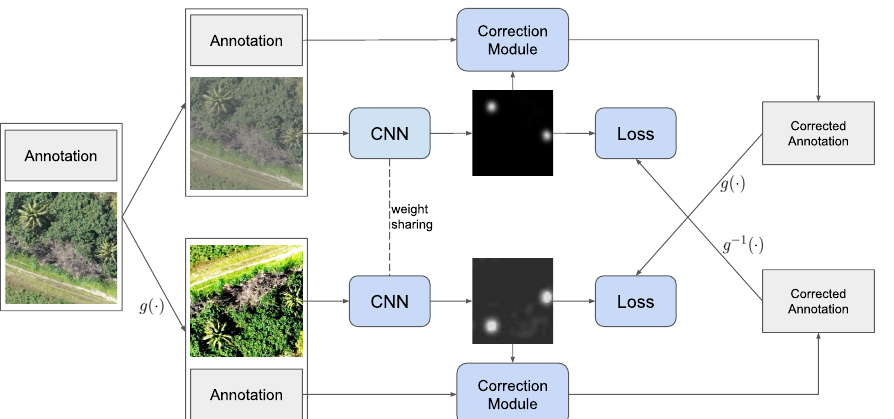
Figure 1. Our proposed co-correction framework. Two image versions are created and fed through a Siamese network. The outputs are used to generate corrected annotations, which are, in turn, employed as supervision for the other branch. In doing so, we need to apply the geometric trans- formation g ( · ) to the upper branch and undo it on the lower branch with g − 1 ( · ) . Aerial image from